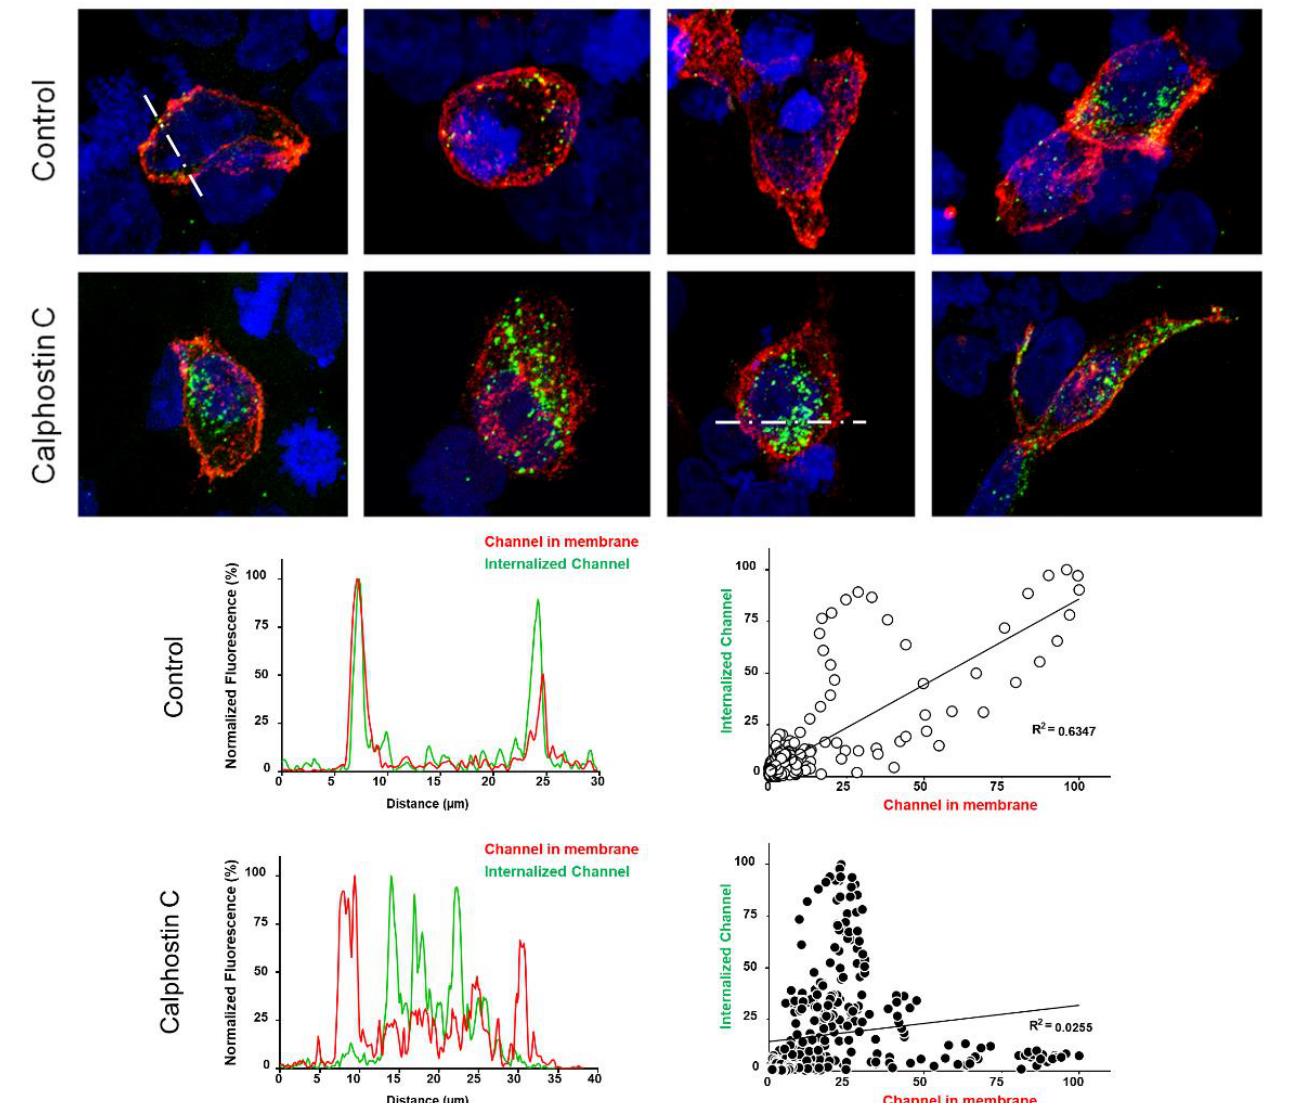
Figure 4. The inhibition of PKC enhances the internalization of K V 1.5–K V β 1.3 channels. Representative confocal images of HEK293 cells transfected with K V 1.5–K V β 1.3 under control conditions and after treatment with calphostin C. Fluorescence profiles and fluorescence correlation of internalized channels and plasma membrane ones (bottom) in control and after calphostin-C treatment. Note that control cells show mostly a high red signal (plasma membrane channels), whereas those treated with calphostin C present a weaker red signal, but a much greater green signal (internalized channels, which did not recycle to the cell membrane).